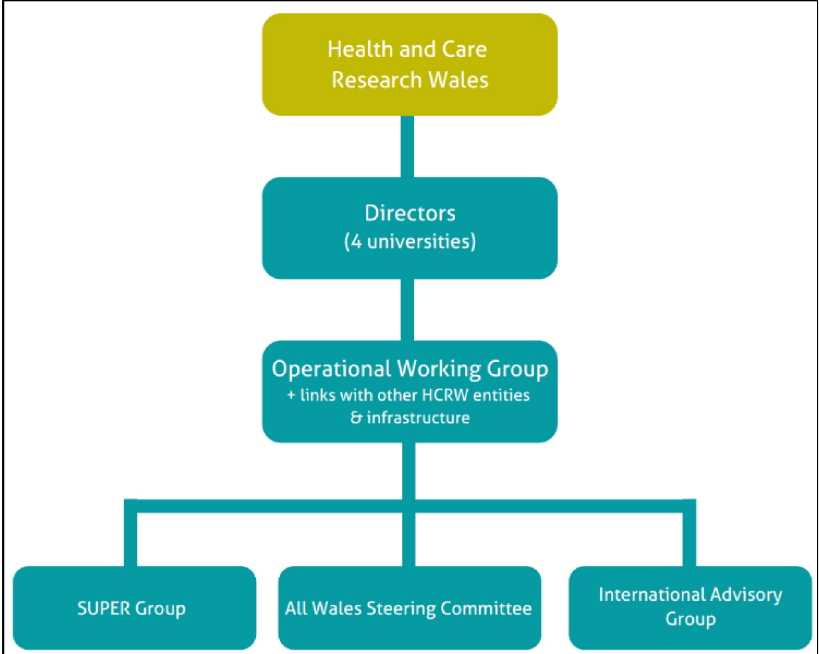
Figure 2: Organisational structure of PRIME Centre